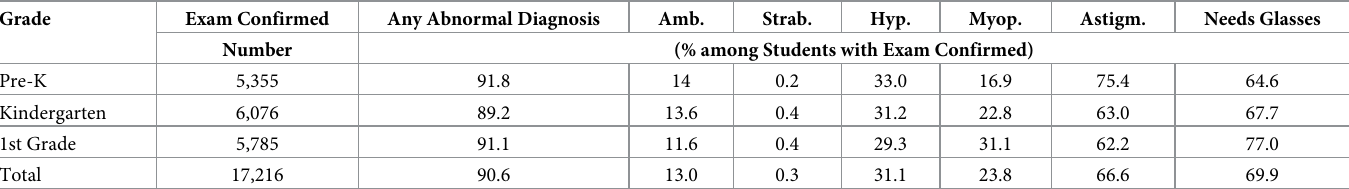
Table 3. Rates of abnormal diagnoses among screened students with eye exams confirmed in Pre-K through 1 st grade, 2018–19.